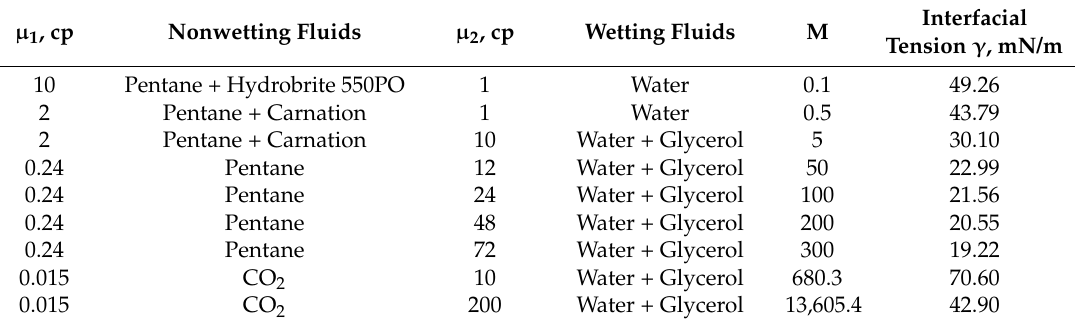
Table 1. Drainage experiments fluids.